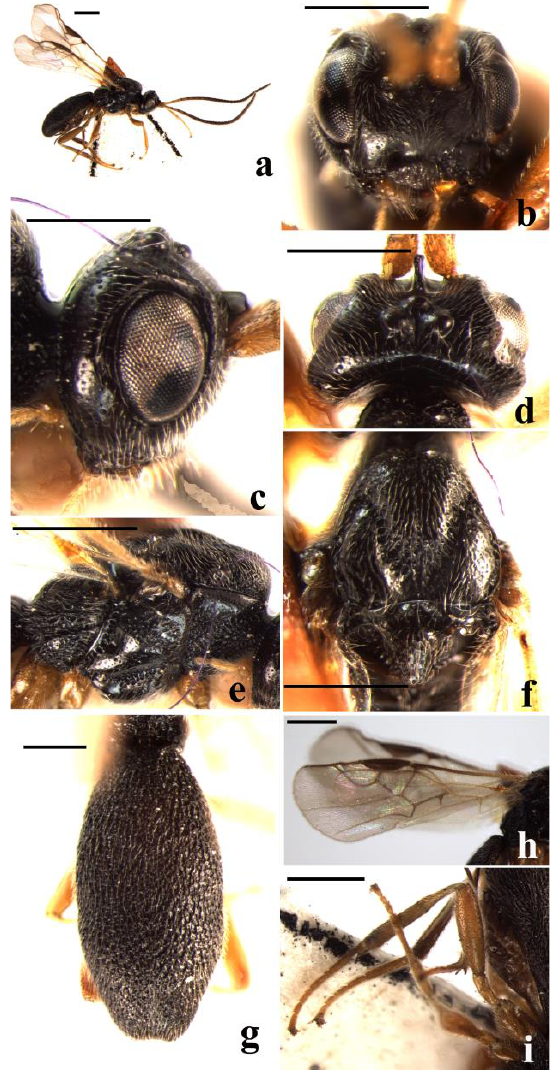
Figure 5. Schizoprymnus punctiscutellaris sp. nov., holotype, ♀ . ( a ) Habitus, lateral aspect; ( b ) head, frontal aspect; ( c ) head, lateral aspect; ( d ) head, dorsal aspect; ( e ) mesosoma, lateral aspect; ( f ) mesoscutum, dorsal aspect; ( g ) carapace, dorsal aspect; ( h ) fore wing; ( i ) hind leg, lateral aspect. Scale bar: 1 mm.